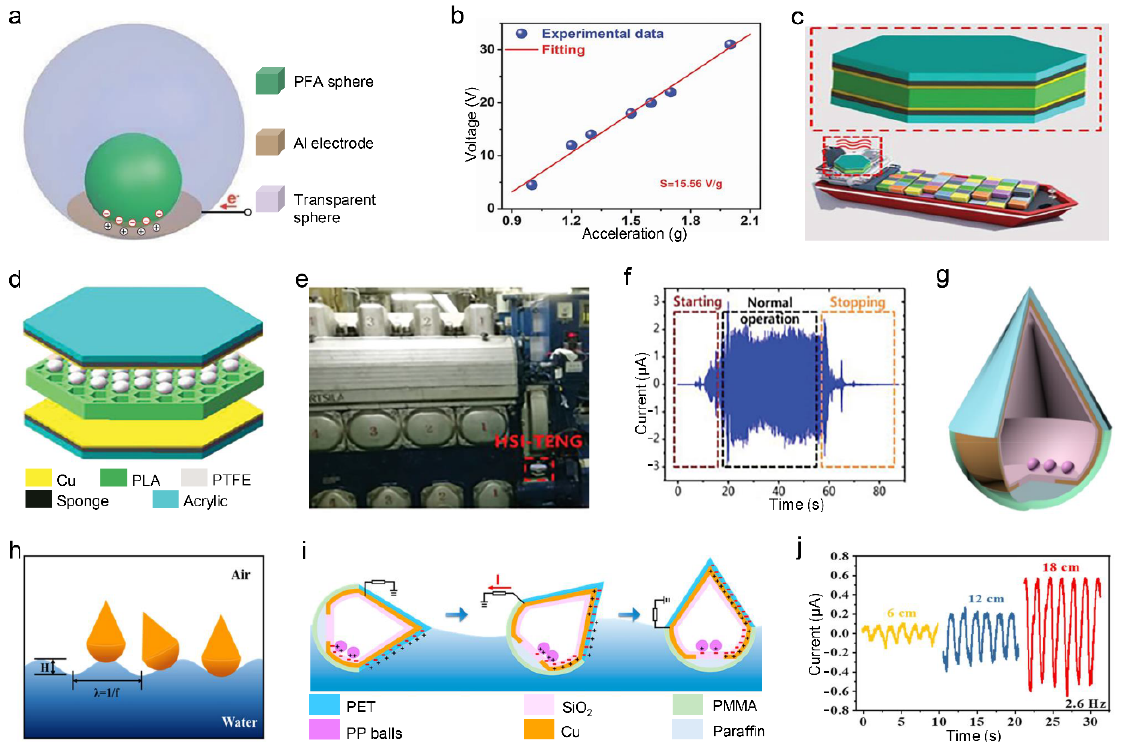
Figure 8. A curved surface contact vibration sensor: Part One. ( a ) Structure design of the 3D-TENG. ( b ) Relationship between the output voltage and acceleration. Reproduced with permission [92].